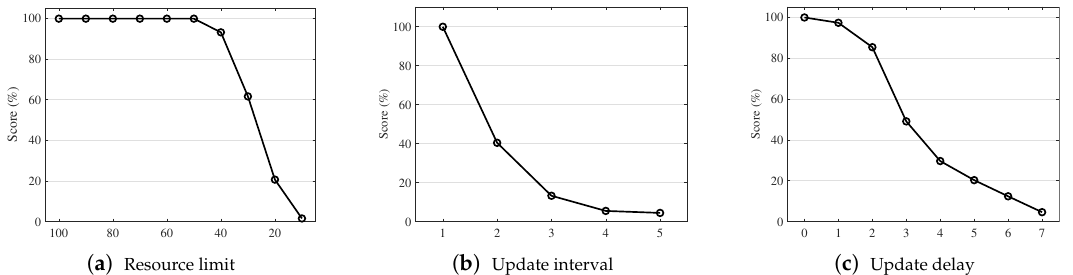
Figure 1. Effects of resource restriction: The driving test score of the simulator [6] with respect to ( a ) resource utilization limits for sensor data updates in percentages, where higher limits indicate more resource usages (on the X-axis); ( b ) average time interval in frames for consecutive updates of sensor data where large intervals indicate less resource usages; and ( c ) average time delay in frames for consecutive updates of sensor data where longer delays indicate less resource usage.